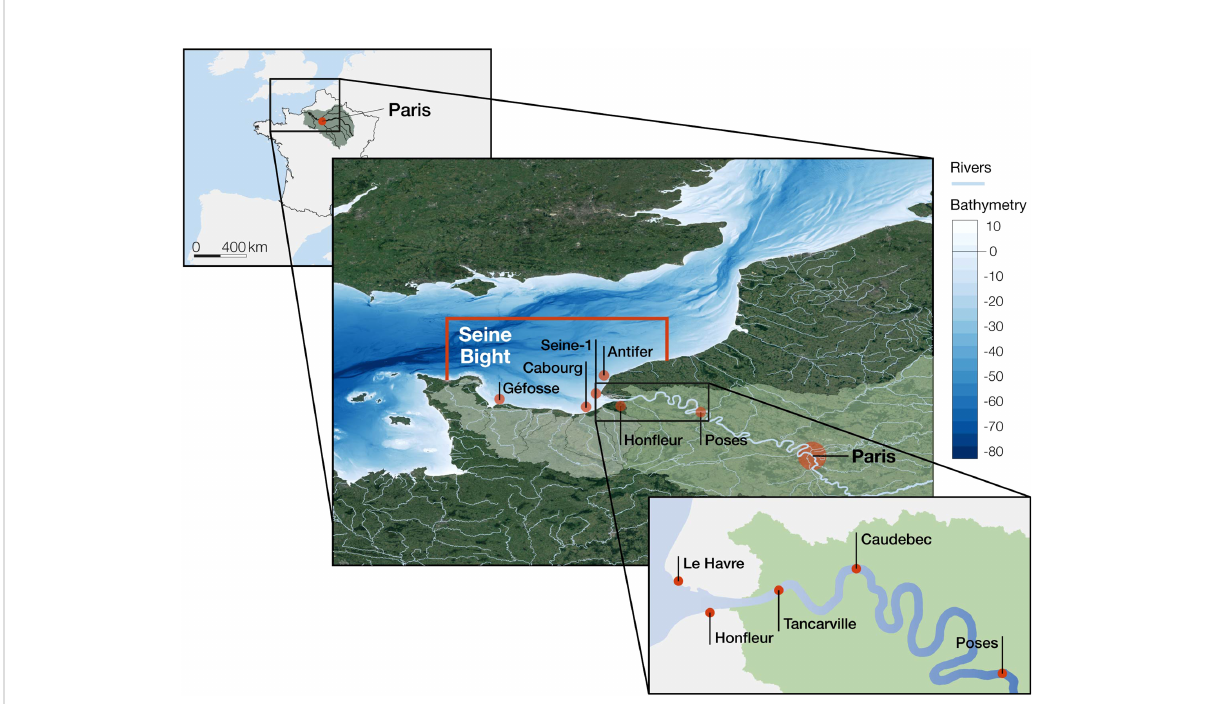
FIGURE 1 (left) The Seine basin in France; (middle) The lower part of the basin and the Seine Bight, showing the marine limits of the ECO-MARS3D model (red lines), the marine stations and the coastal river basins that fl ow into the Seine Bight and that are also considered in the study (W to E, Saire, Douve, Taute, Vire, Aure, Seulles, Orne, Dives et Touques). (right) A zoom on the